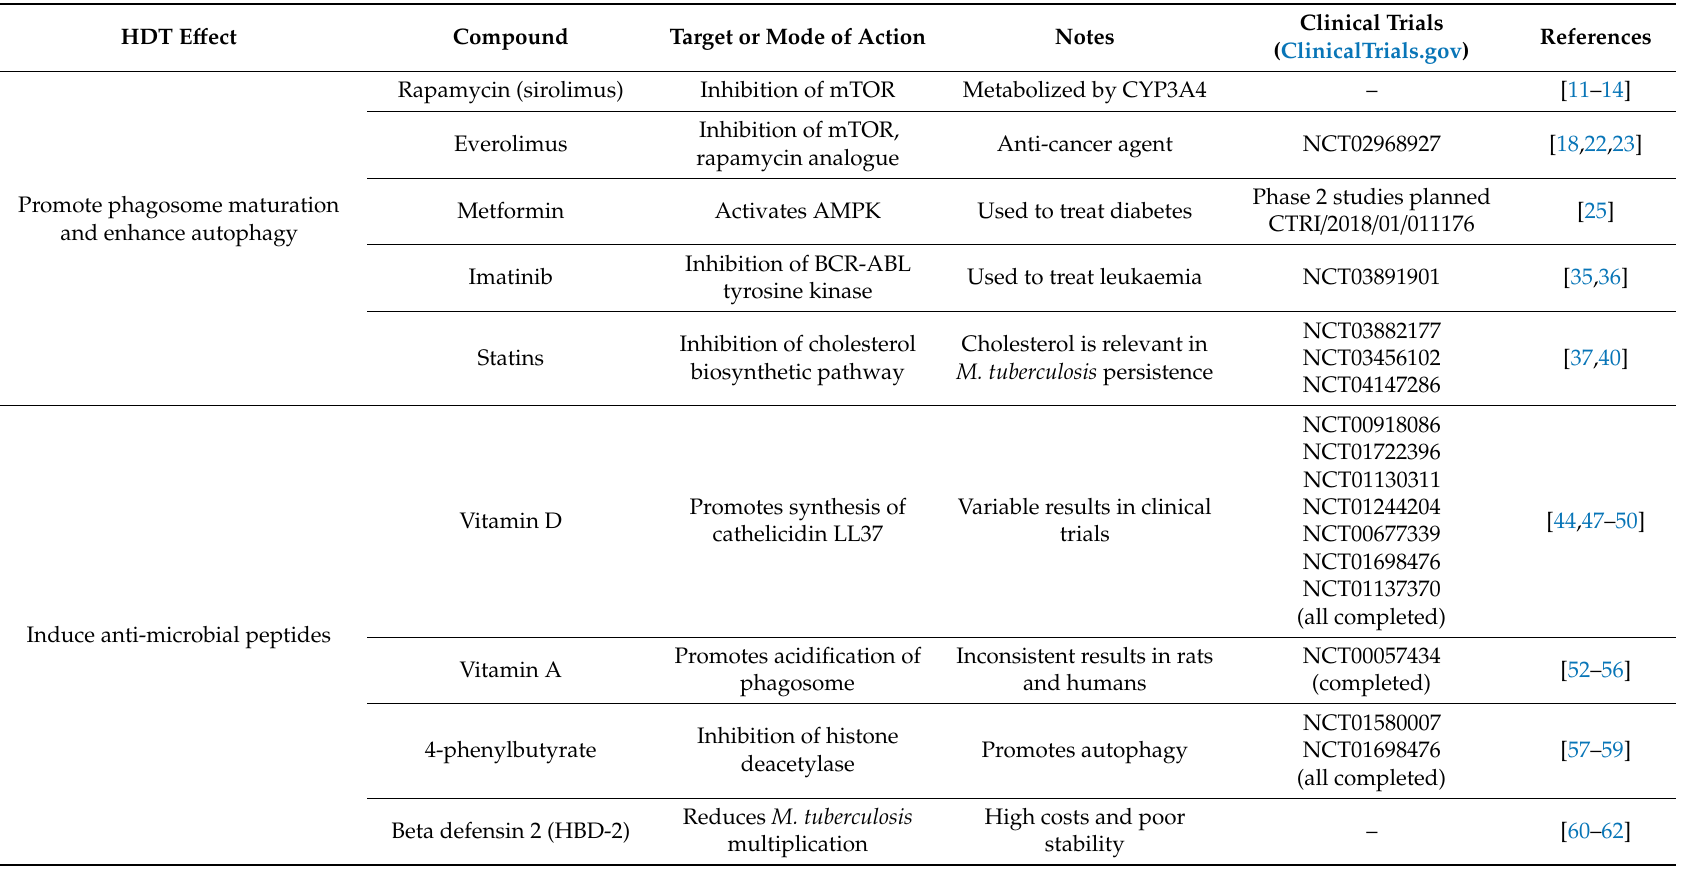
Table 1. Candidate compounds for host-directed therapy (HDT) against tuberculosis